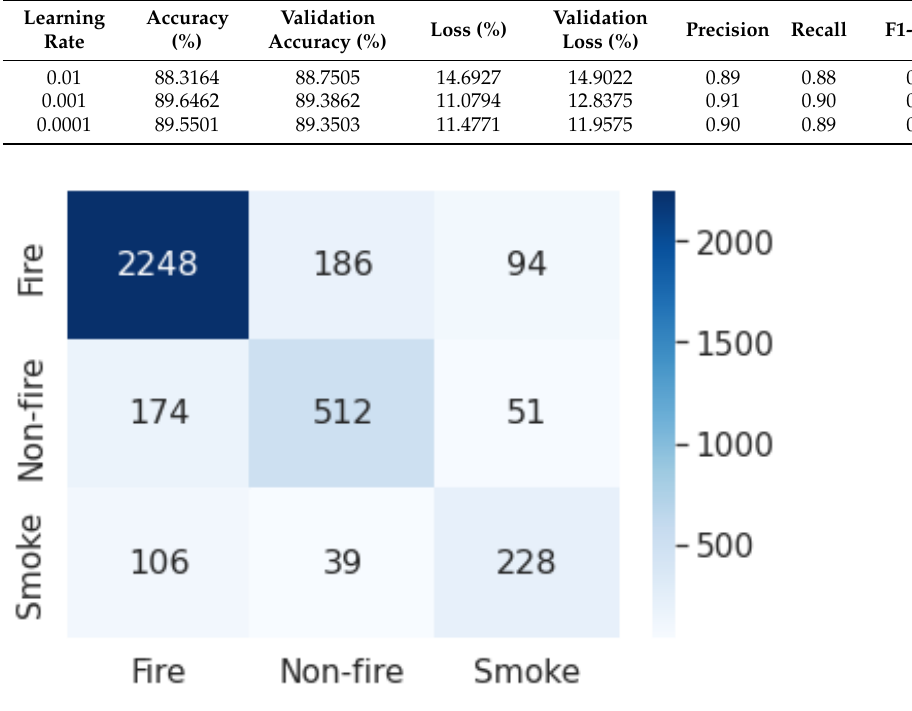
Figure 12. Confusion matrix representation for the CNN model with Adam optimizer and Softmax Activation